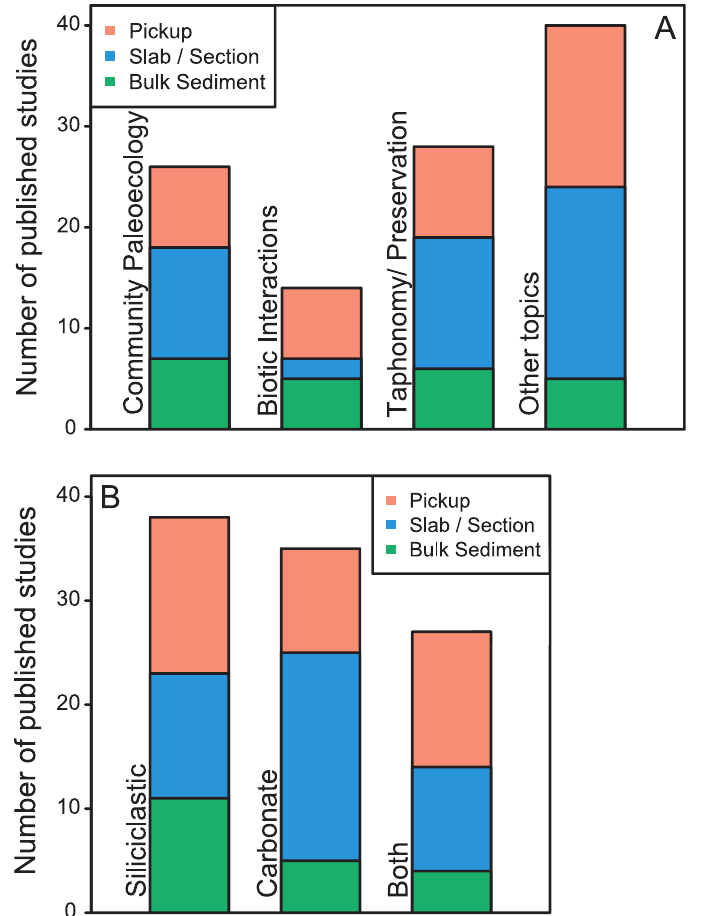
Fig 1. Informal review of fossil collection methods in the literature. A. Fossil collection methods by article topic. B. Fossil collection methods by lithology of the study material. Note, the bar height represents the total number of methods used, not the total number of papers, because single papers sometimes used multiples